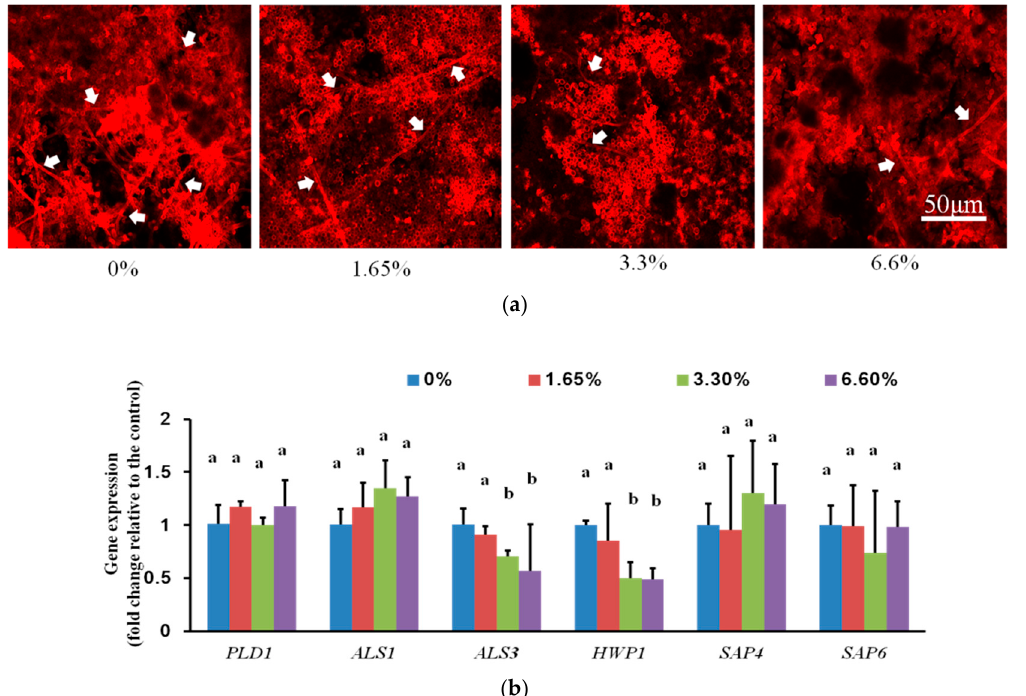
Figure 3. The confocal laser scanning microscope (CLSM) images and relative gene expression of C. albicans in biofilms: ( a ) The CLSM images of C. albicans in multi-species biofilms, C. albicans dyed red, representative hyphae form of C. albicans was marked with white arrows; ( b ) Relative gene expression in C. albicans . Values are significantly different when labelled with different letters ( p < 0.05).